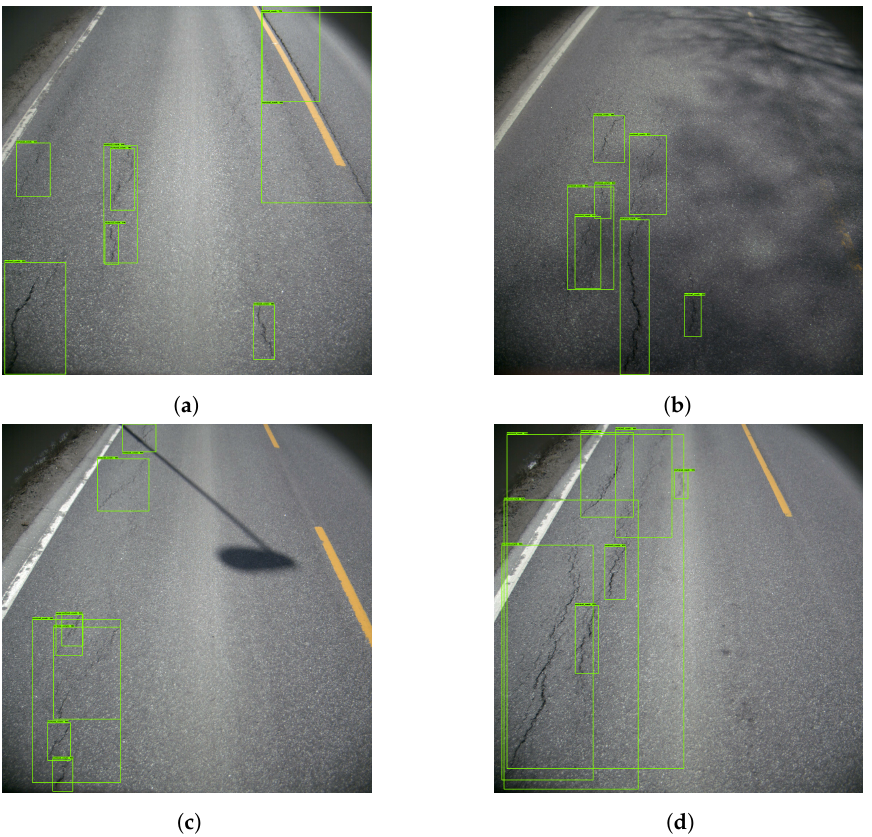
Figure 5. Examples of poor vertical crack detection. The green boxes represents the vertical cracks.